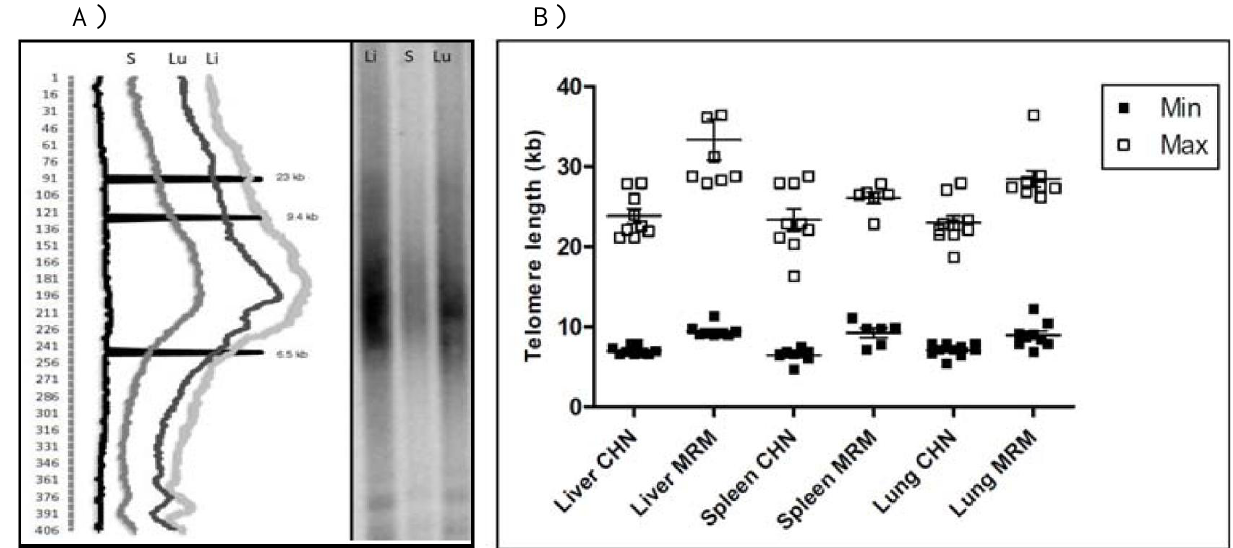
Figure 3. TRFs analysis by densitometry. A) right side: telomere gel with liver (Li), spleen (S) and lung (Lu) samples from a Maremmana cow; left: densitometric analysis of the resulting telomeric profile. Peaks at 23 kb, 9.4 kb and 6.5 kb represent molecular weight markers; the numbers to the left refer to the multiple boxes used to scan the intensity of the signal over the lanes. B) box plot representing the length of the shortest (filled square) and the longest (empty square) telomeres of each sample analyzed. A)